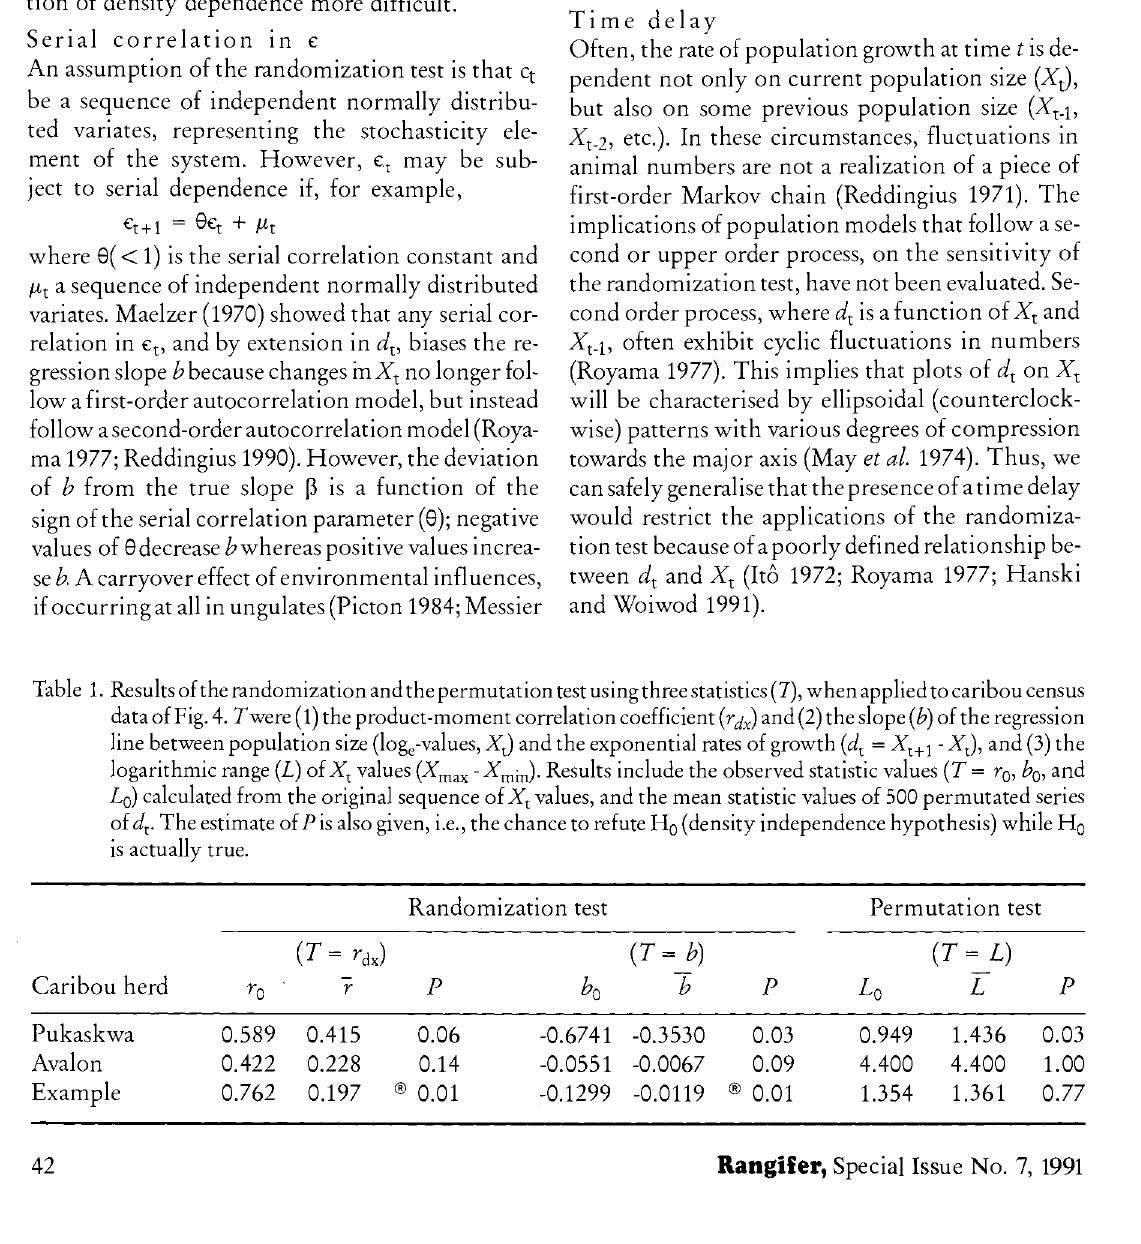
Avalon 0.422 0.228